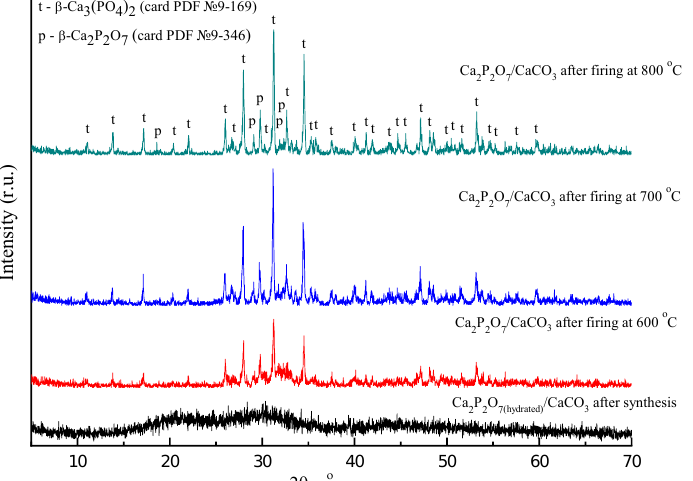
Figure 2. XRD data obtained for CPP/CC sample synthesized from a mixed-anionic solution containing P 2 O 7 4 − and CO 3 2 − after firing at different temperatures: w— β -Ca 3 (PO 4 ) 2 (card PDF № 9-169); p— β -Ca 2 P 2 O 7 (card PDF № 9-346). When the temperature reaches above 700 °C, the X-ray amorphous CPP/CC sample transforms into a product with phase composition mainly represented by β -Ca 3 (PO 4 ) 2 phase with the presence of a small amou nt of β -Ca 2 P 2 O 7 phase (~20 wt % for a sample fired at 800 °C). The formation of the β -Ca 3 (PO 4 ) 2 phase occurs in accordance with the heterophase reaction (5). Mass spectrometry data indicate that this process takes place in the temperature range of 400 – 600 °C. The XRD data are consistent with thermal analysis (Figure 3) and mass spectrometry data (Figure 4).